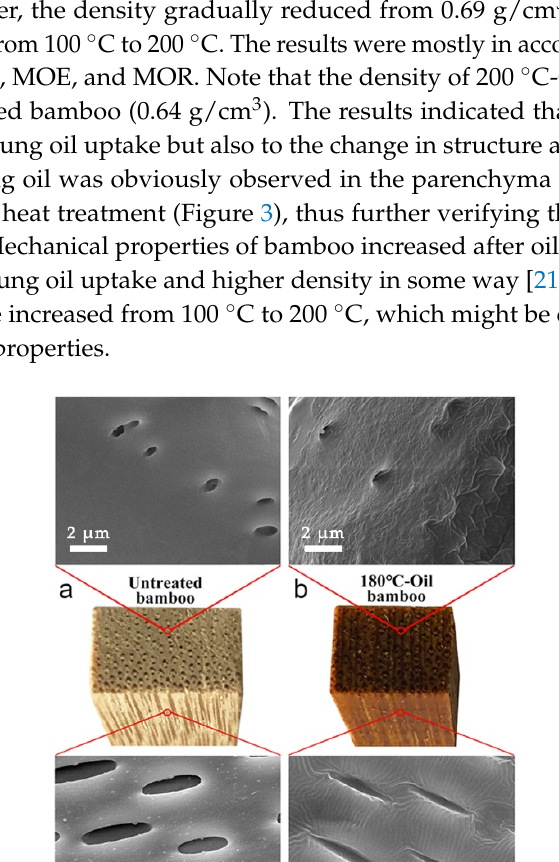
Table 1. The physical and bending mechanical properties of moso bamboo.